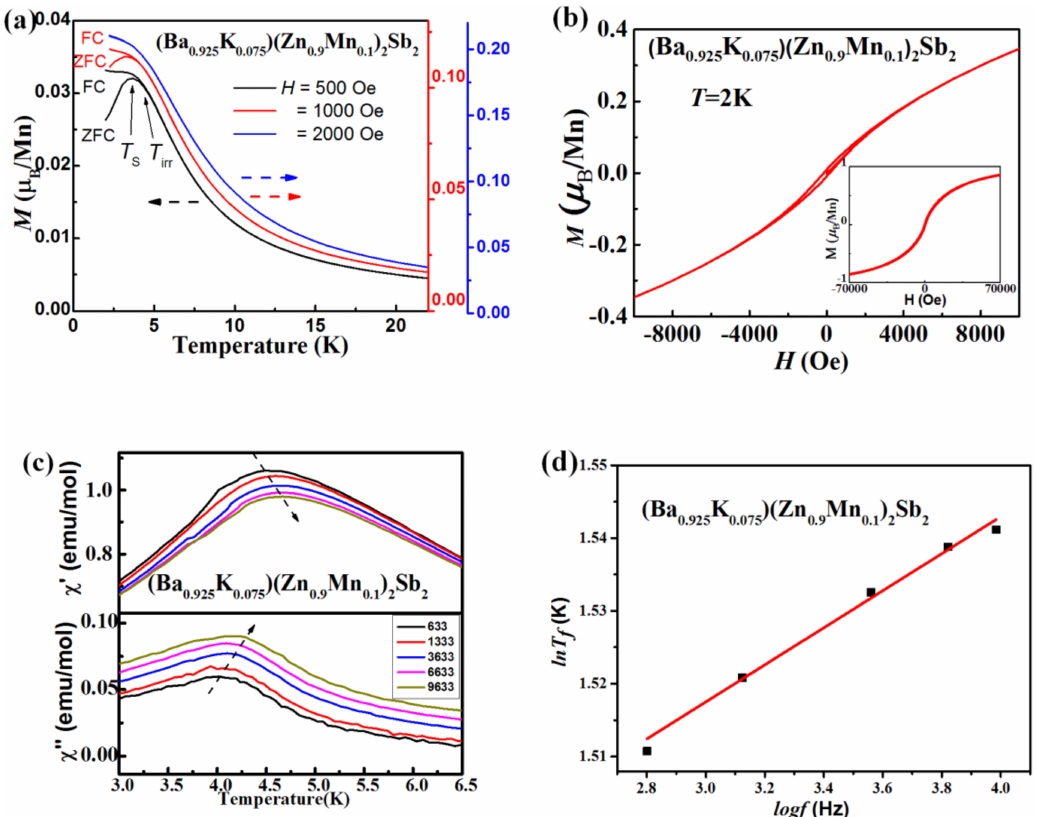
Figure 3. ( a ) DC M ( T ) measured under H = 500 Oe (black curves), 1000 Oe (red curves) and 2000 Oe (blue curves) of (Ba 0.925 K 0.075 )(Zn 0.9 Mn 0.1 ) 2 Sb 2 ; ( b ) the hysteresis loops at 2 K of (Ba 0.925 K 0.075 )(Zn 0.9 Mn 0.1 ) 2 Sb 2 ; ( c ) AC χ ’( T ) and χ ”( T )of (Ba 0.925 K 0.075 )(Zn 0.9 Mn 0.1 ) 2 Sb 2 at various frequencies; ( d ) frequency dependence of transition temperature of (Ba 0.925 K 0.075 )(Zn 0.9 Mn 0.1 ) 2 Sb 2